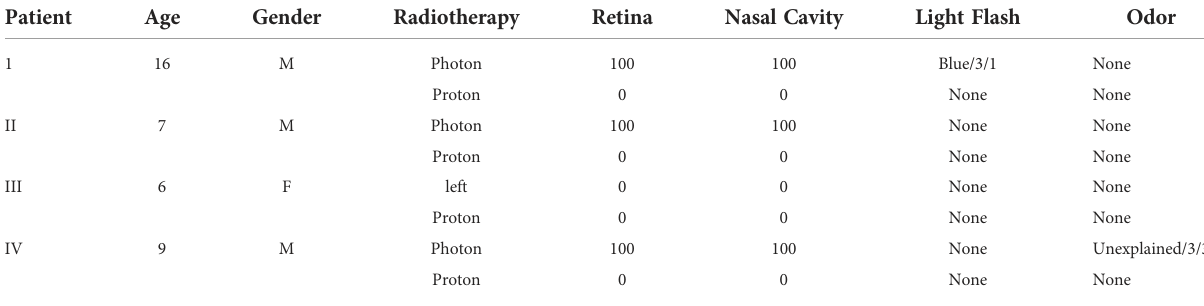
TABLE 3 Details of abnormal sensations in patients who received multiple courses of radiotherapy.